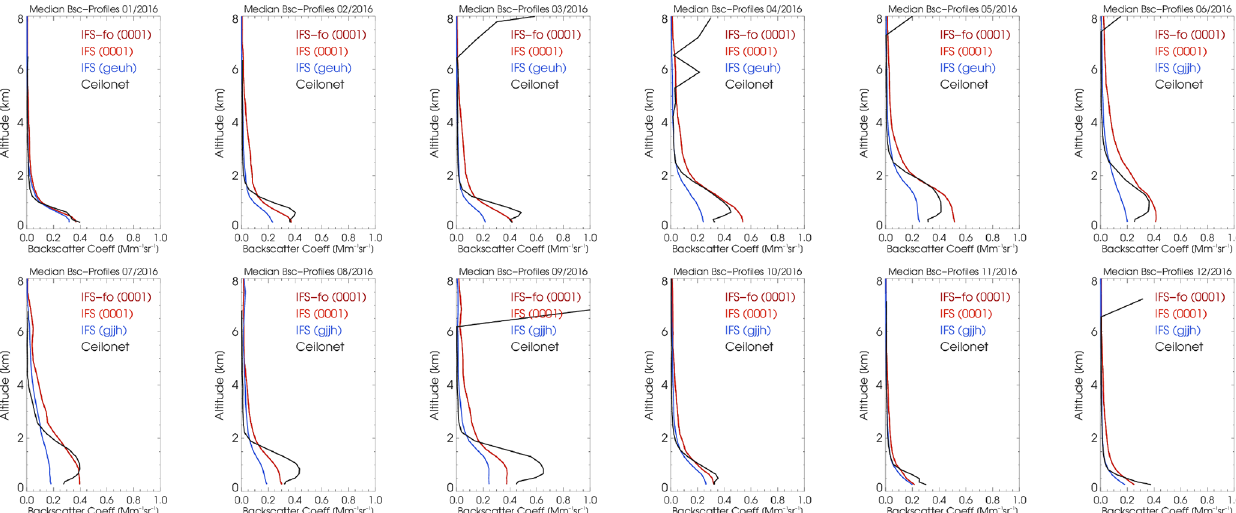
Figure D1. Monthly median profiles 2016 from the ceilometer (black), ASM (red) and control run (blue).